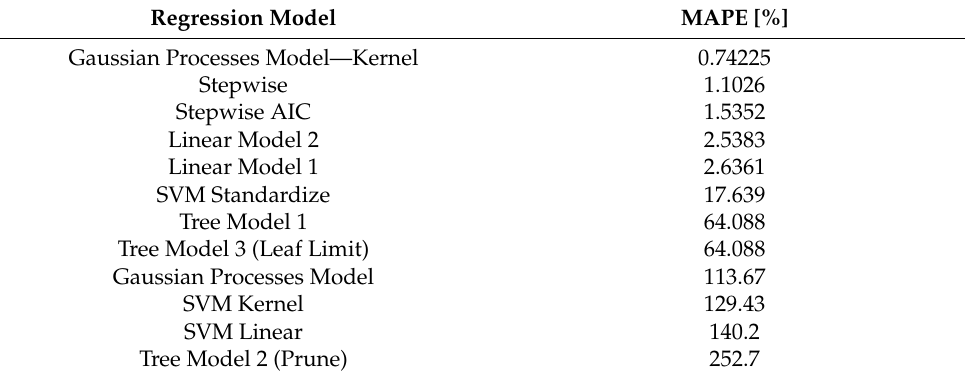
Table 4. Computational results for mdl in the operation system for the test object with BESS